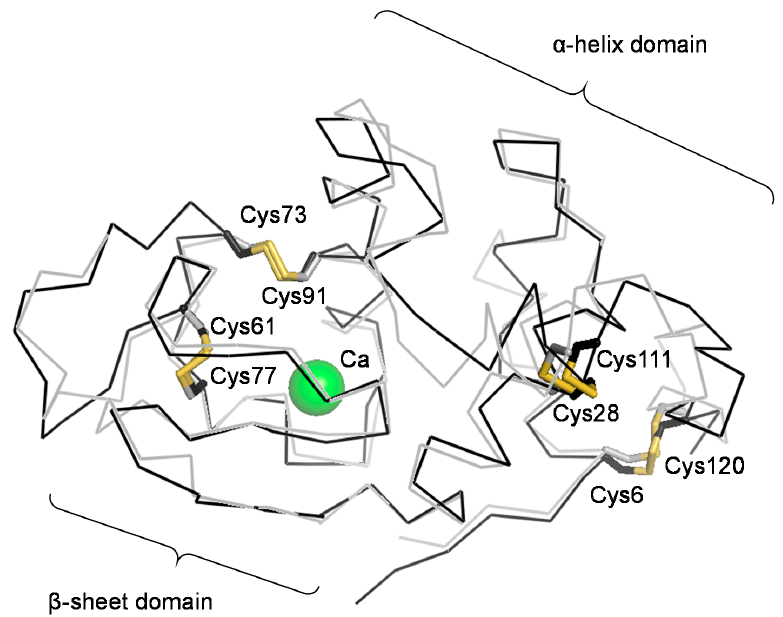
Figure 1. Molecular structure of bovine milk α LA (black, pdbcode: 1hfz) superimposed onto the structure of HEL (gray, pdbcode: 6lyz). Locations of Ca 2+ (green) and SS bonds (yellow) of α LA are shown.